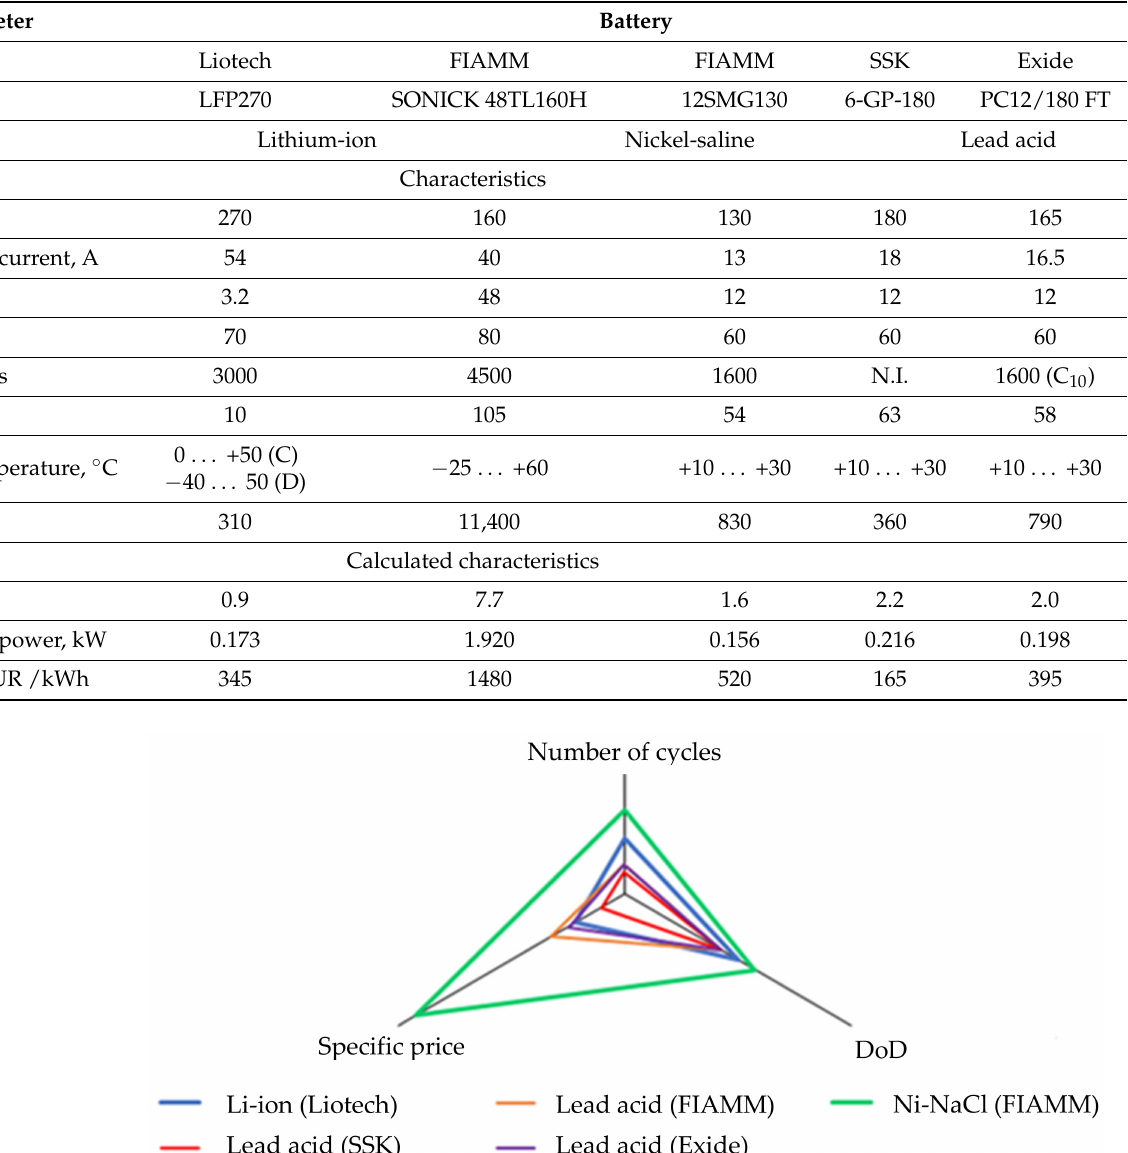
Figure 4. Some critical batteries